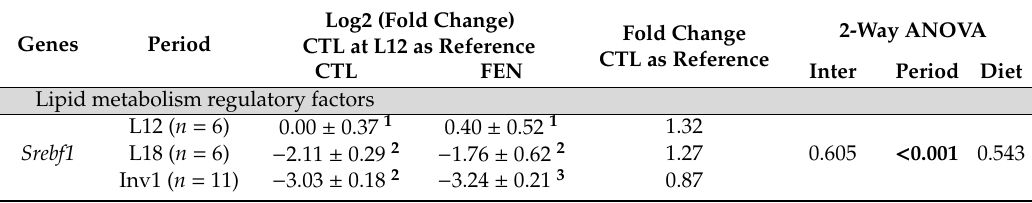
Table 4. E ff ect of fenugreek on relative expression of genes related to milk synthesis regulatory factors in the mammary gland along lactation